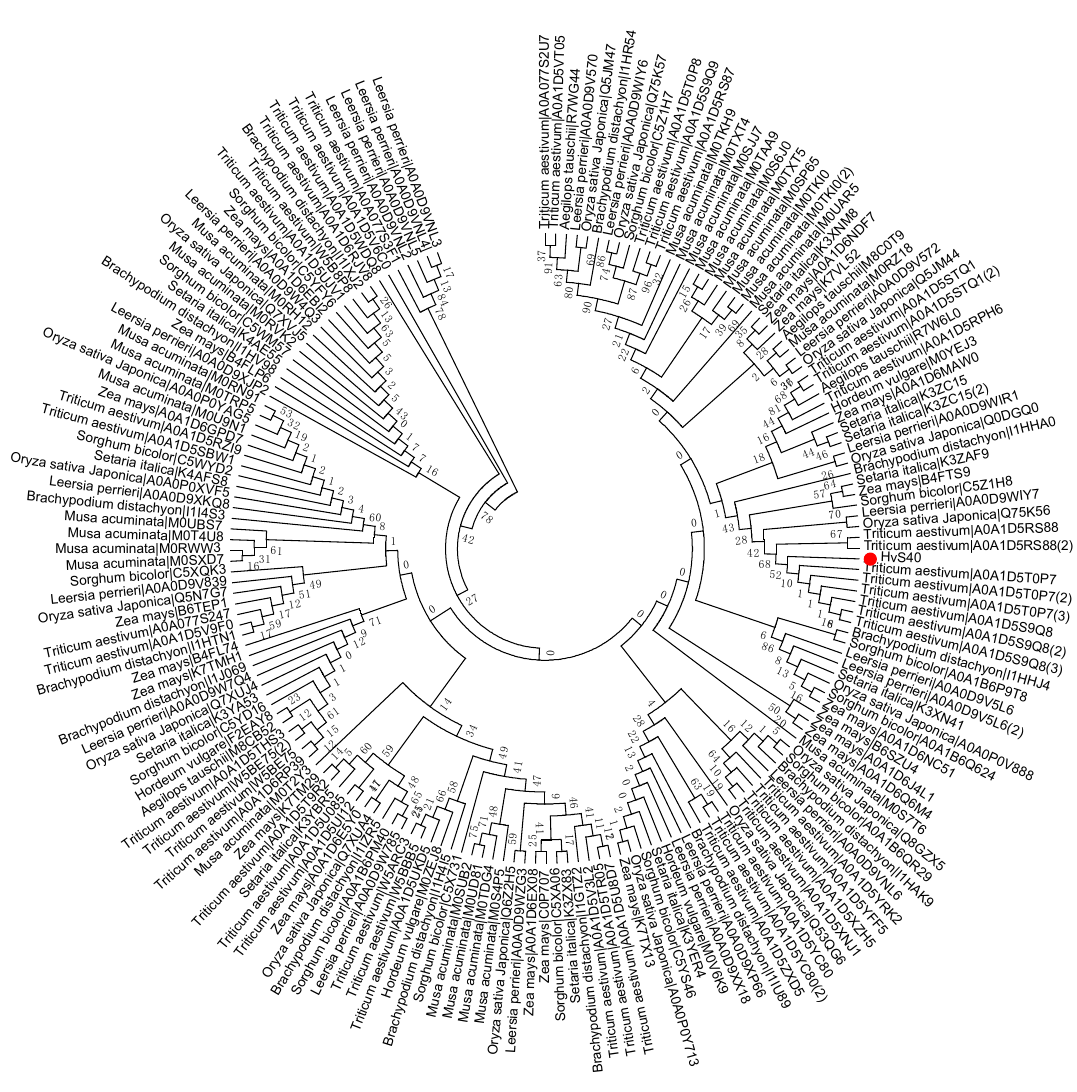
Figure 3. Phylogenetic tree of the S40 gene family in sequenced genome monocot plants including Aegilops tauschii, Brachypodium distachyon, Hordeum vulgare, Leersia perrieri, Musa acuminate, Oryza sativa Japonica, Setaria italica, Sorghum bicolor, Triticum aestivum, Zea mays. Red dot